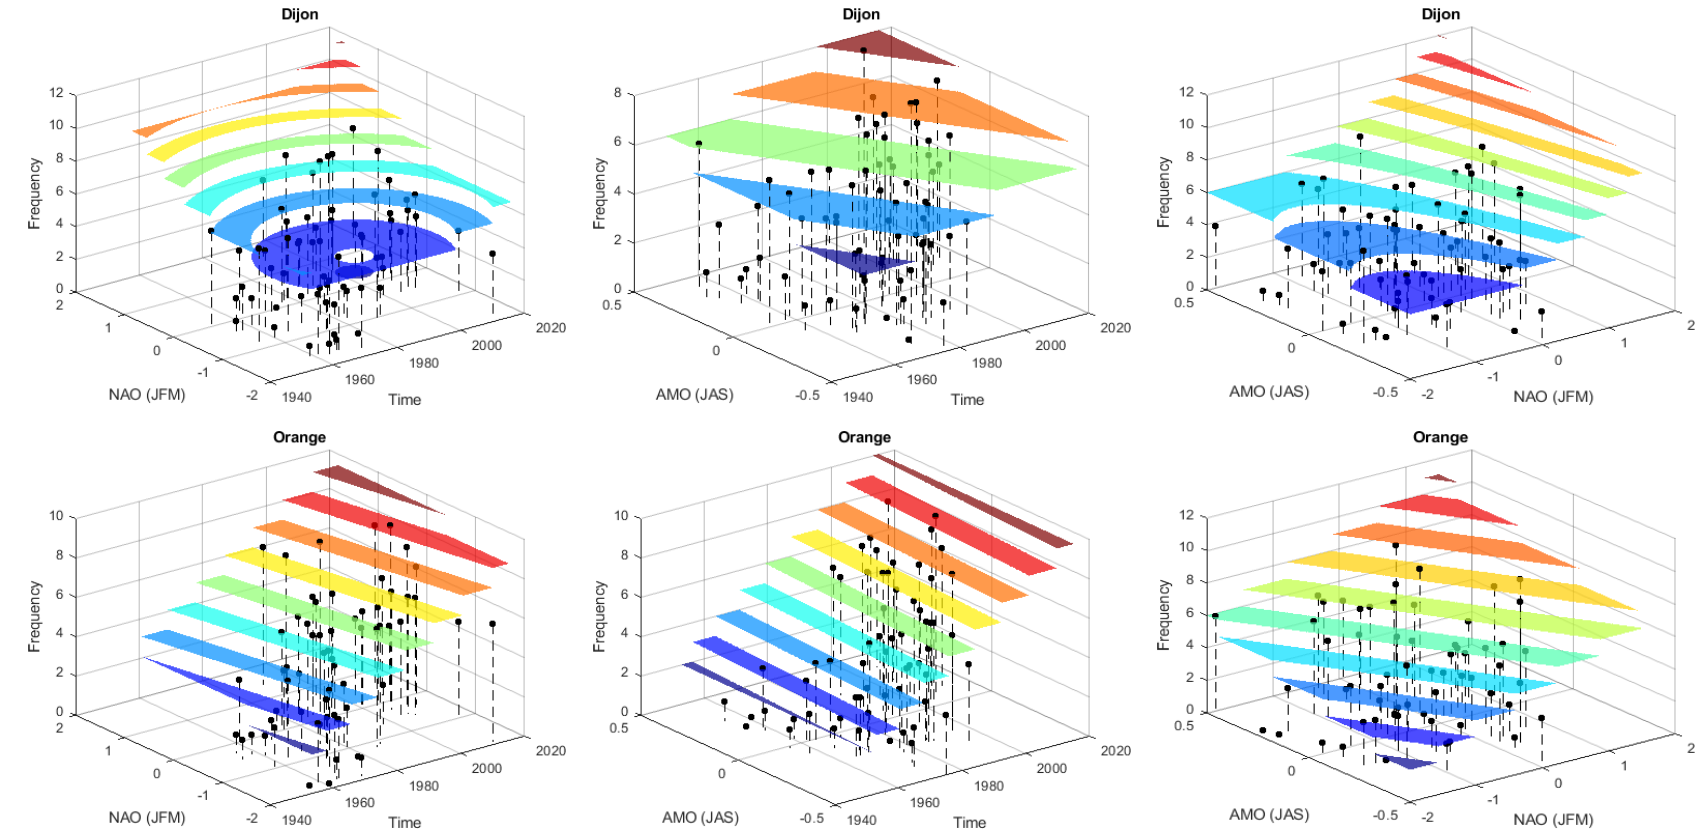
Figure 9. Frequency quantiles corresponding to the non-exceedance probability p = 0.9 as a function of the combination of two covariates.